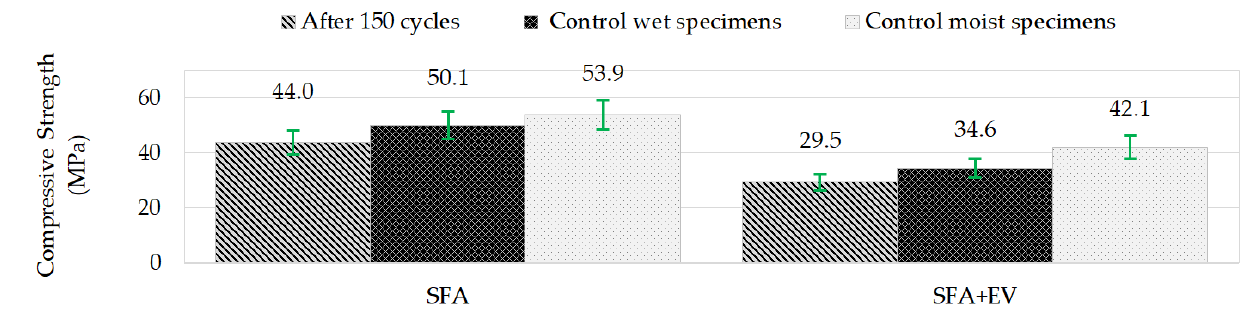
Figure 10. Compressive strength before and after freeze/thaw cycles.